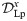
Prototype atoms, which generate by translation the dictionaries DLpx (left) and DLwx (right).